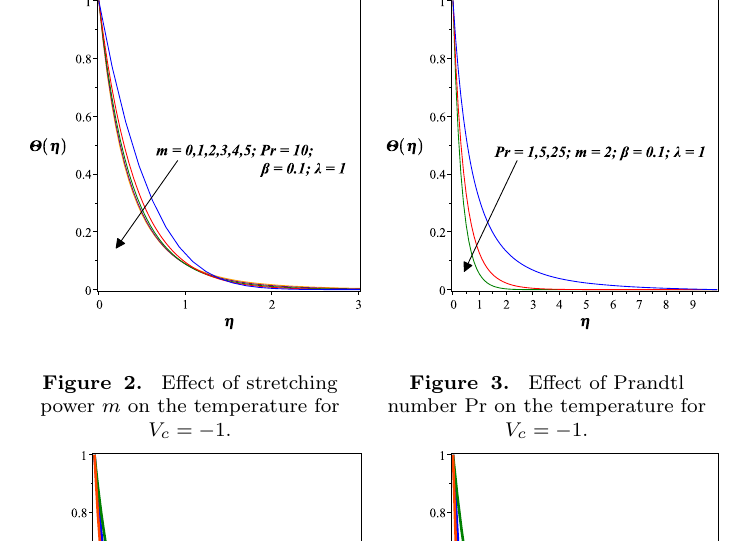
Figure 2. Effect of stretching power m on the temperature for V c = − 1.